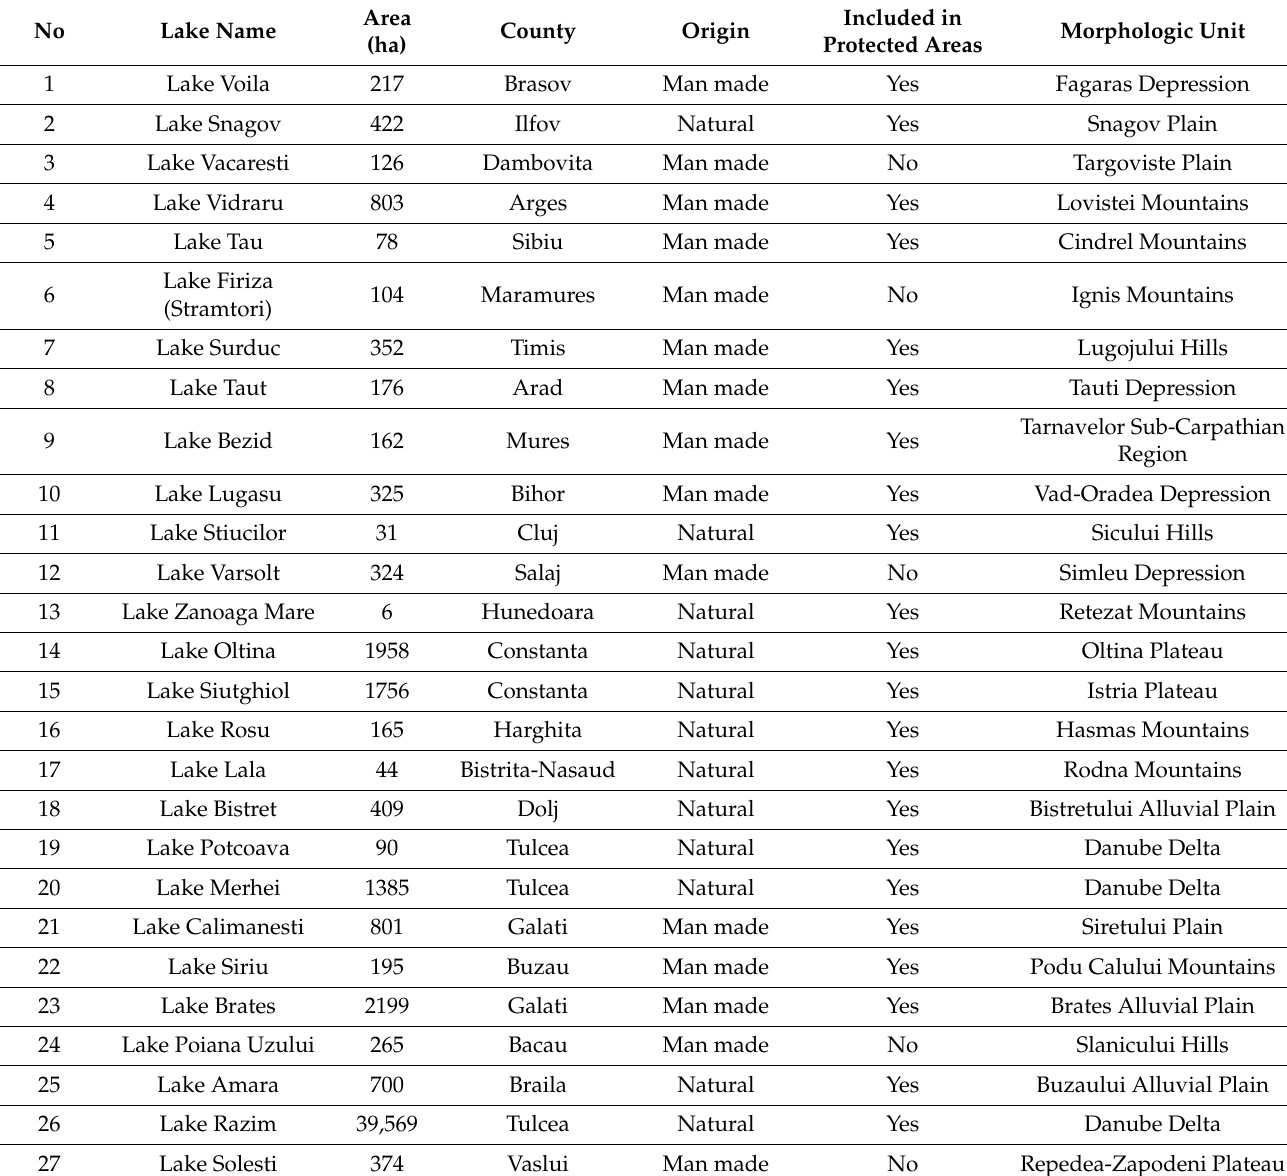
Table 6. The lake ecosystems evaluated for